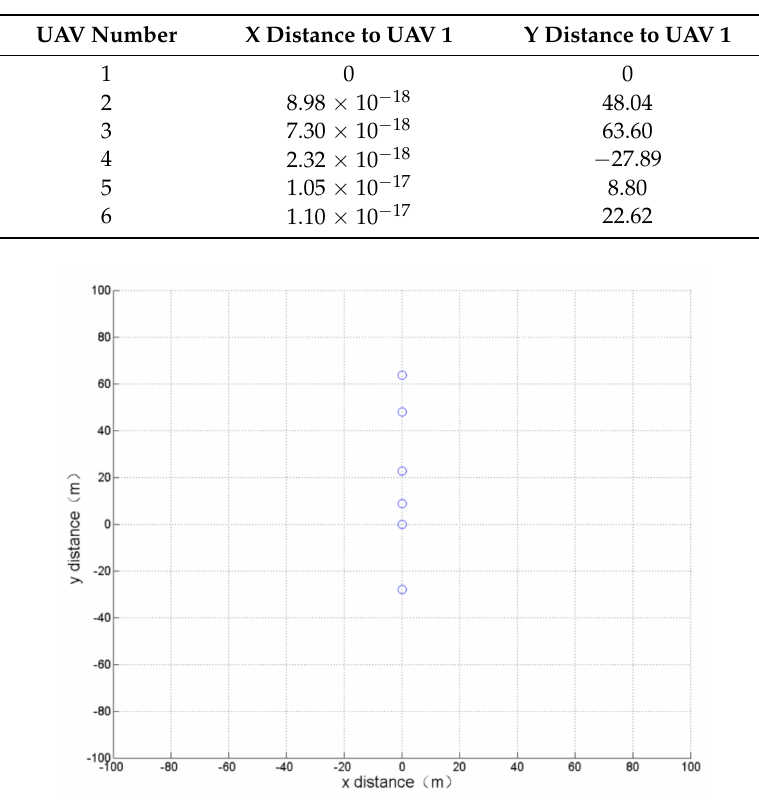
Figure 6. Formation optimization results of minimum formation horizontal distance.